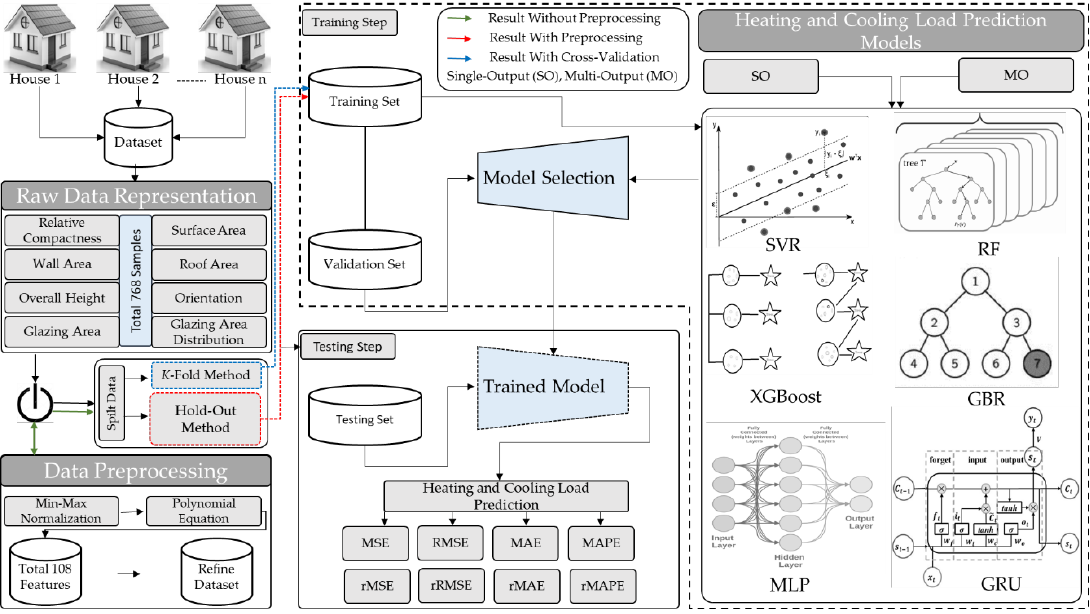
Figure 2. The proposed framework for precise prediction of HL and CL through energy efficiency data using sequential learning model. Table 2. Parameters and their abbreviations.